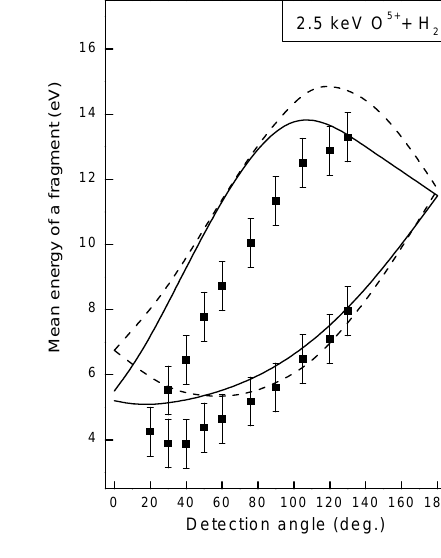
5+ + H collisions at 75 keV and 2